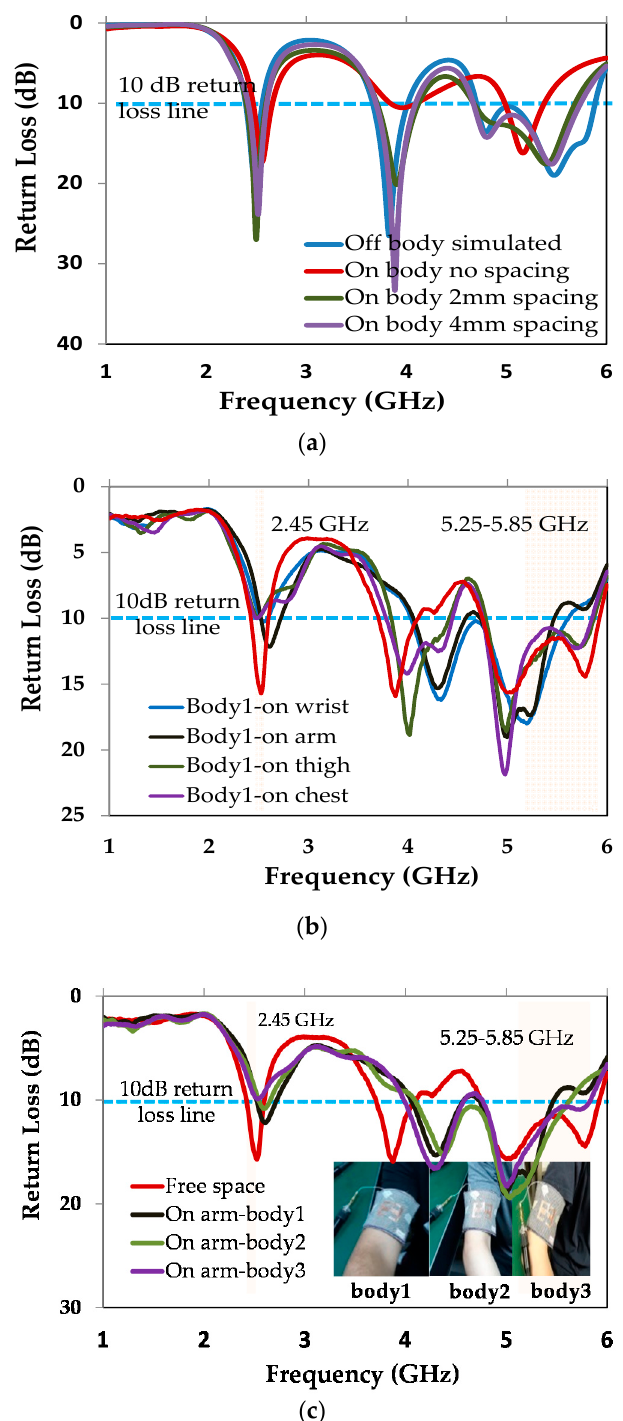
Figure 10. On body measurements: ( a ) Influence of the biological model on the antenna’s performance ( b ) In proximity to the human body 1 and ( c ) on the arm of different bodies.